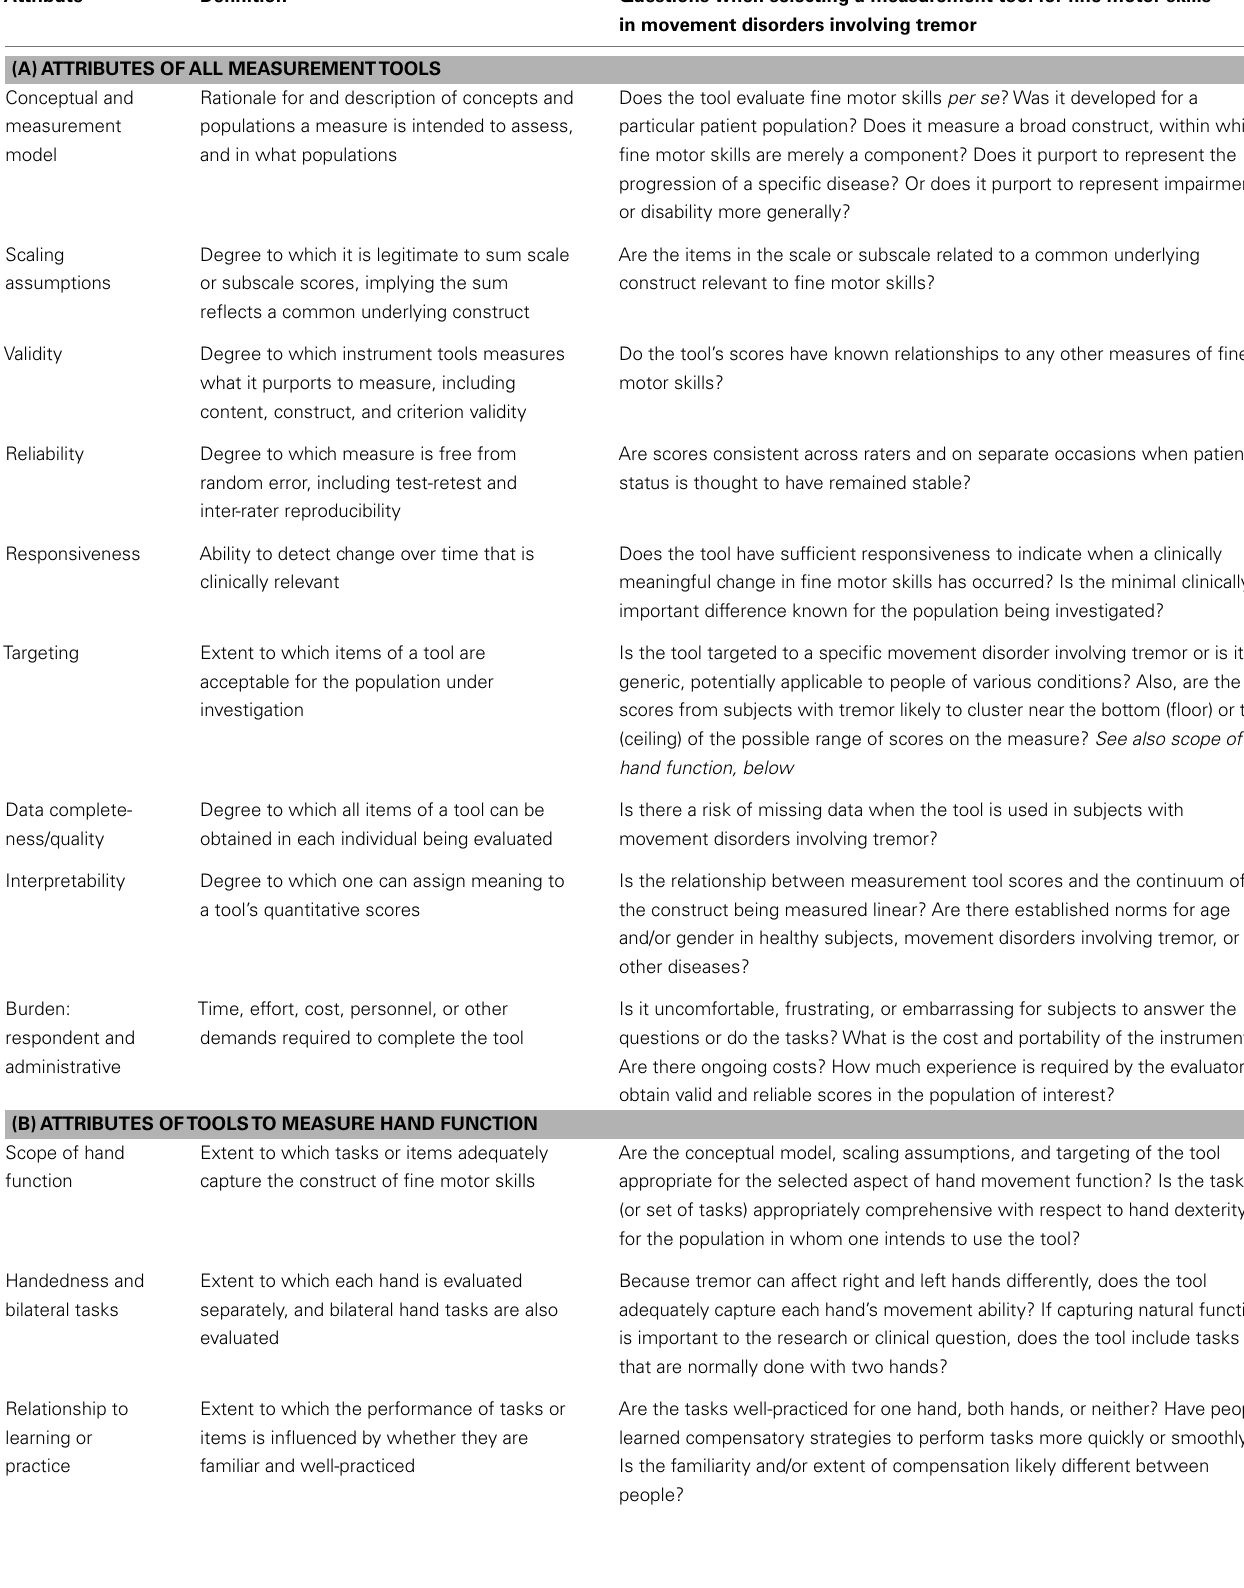
Table 1 |Attributes of measurement